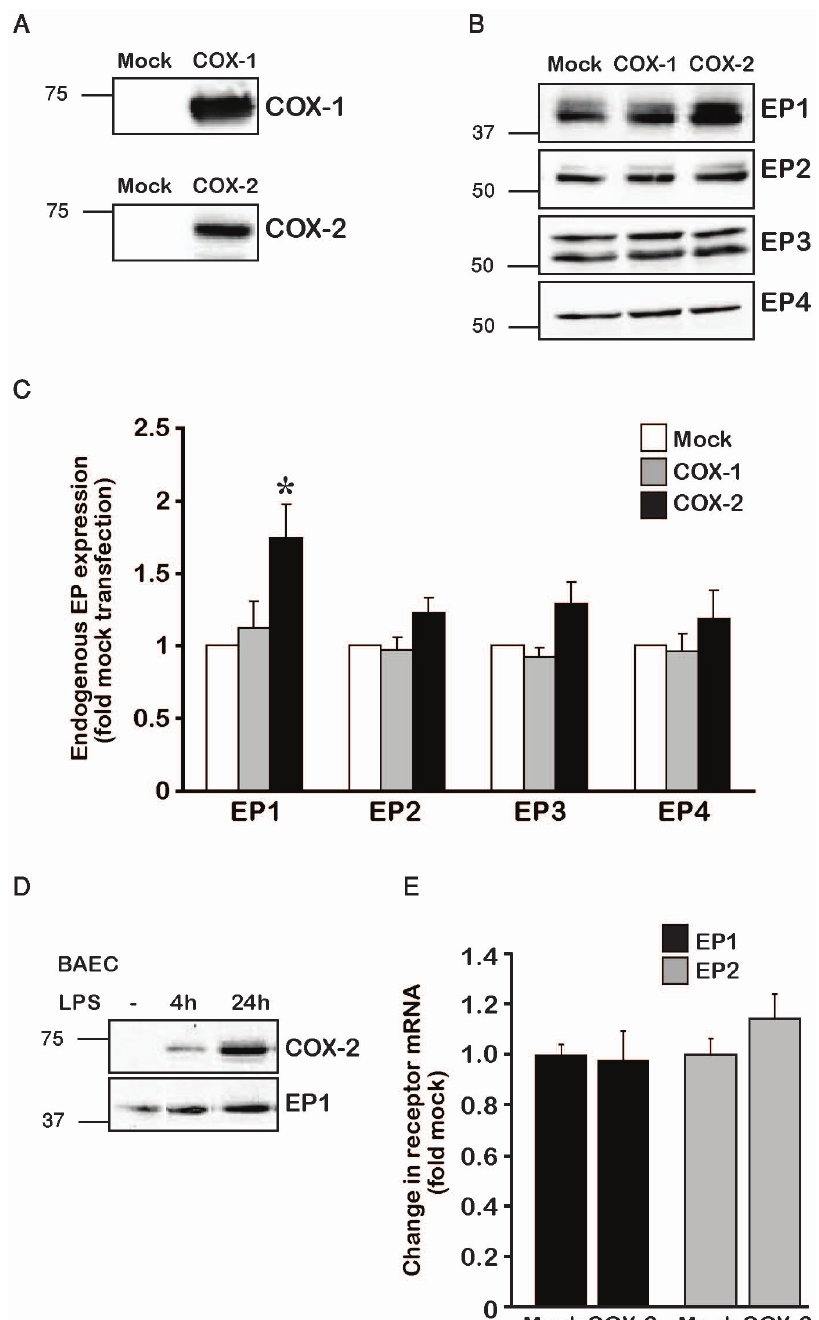
Figure 1. Overexpression of COX-2 raises endogenous levels of EP 1 . A , HEK 293 cells do not express detectable levels of COXs. Representative immunoblot of cell lysates transfected with 0.5 m g empty vector (pcDNA3.1, Mock) or wt COX-1 (upper panel) or COX-2 (lower panel). B , Effect of COX-1 and COX-2 overexpression on EP receptor levels. Representative immunoblots of cells were transfected with 0.5 m g mock, COX-1 or COX-2. Endogenous expression of EP receptor levels was determined using specific antibodies. C , Summary graph of the effect of COX overexpression on EP levels n=7–9 different experiments. Shown are mean + SEM *p , 0.05 vs. Mock transfection. D , Bovine aortic endothelial cells (BAEC) were treated with 1 m M LPS for the indicated times. Lysates were collected and probed for COX-2 and EP 1 levels. E , HEK 293 cells were transfected with 0.5 m g COX-2 or mock and samples were analyzed for content of endogenously expressing EP 1 or EP 2 mRNA using real-time PCR. n=3 independent experiments performed in triplicates. P=0.386 vs. mock. doi:10.1371/journal.pone.0091018.g001 concentrations of AA and found that the association of COX-2 (Fig. 2C upper panel). Since catalysis of AA by COX-2 yields and EP 1 was in reverse correlation to the amount of AA, with different metabolites that activate the ERK signaling pathway decreased association as the amounts of AA were increased through numerous prostanoid receptors including EP 1 [17], we